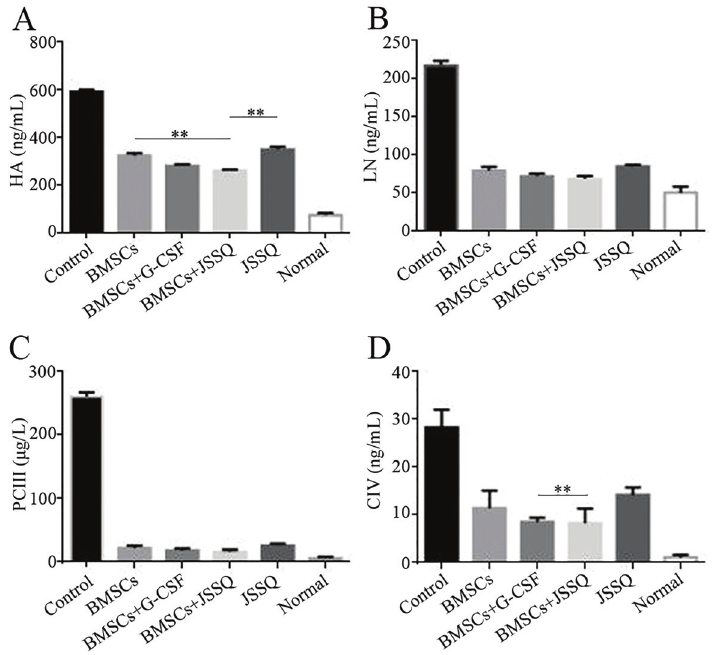
Figure 3. Detection of hepatic fi brosis after differ- ent methods of bone marrow-derived mesenchy- mal stem cells (BMSCs) transplantation in the treatment of liver cirrhosis in rats. G-CSF: granu- locyte colony-stimulating factor; JSSQ: Jisheng Shenqi decoction. Levels of hyaluronidase (HA) ( A ), laminin (LN) ( B ), type III procollagen (PCIII) ( C ), and type IV collagen (CIV) ( D ) are shown. Data are reported as means ± SD. **P o 0.01